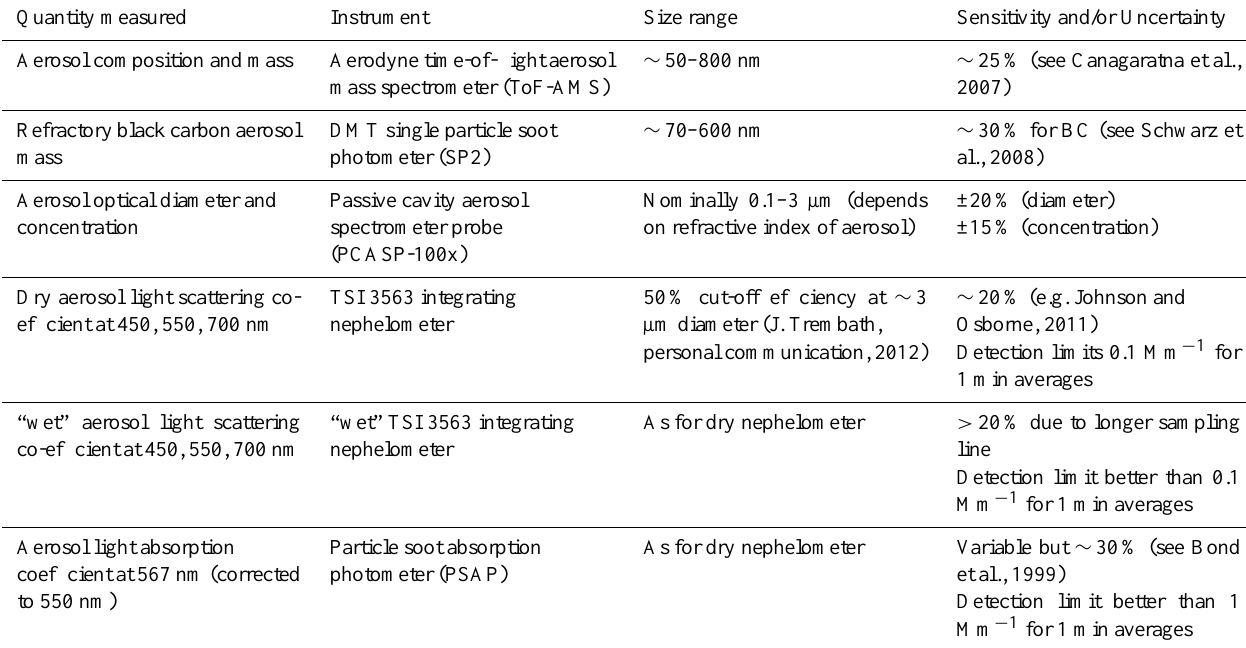
Table 2. Summary of the in-situ aerosol sampling instrumentation on the FAAM BAe146 during the EUCAARI campaign. Quantity